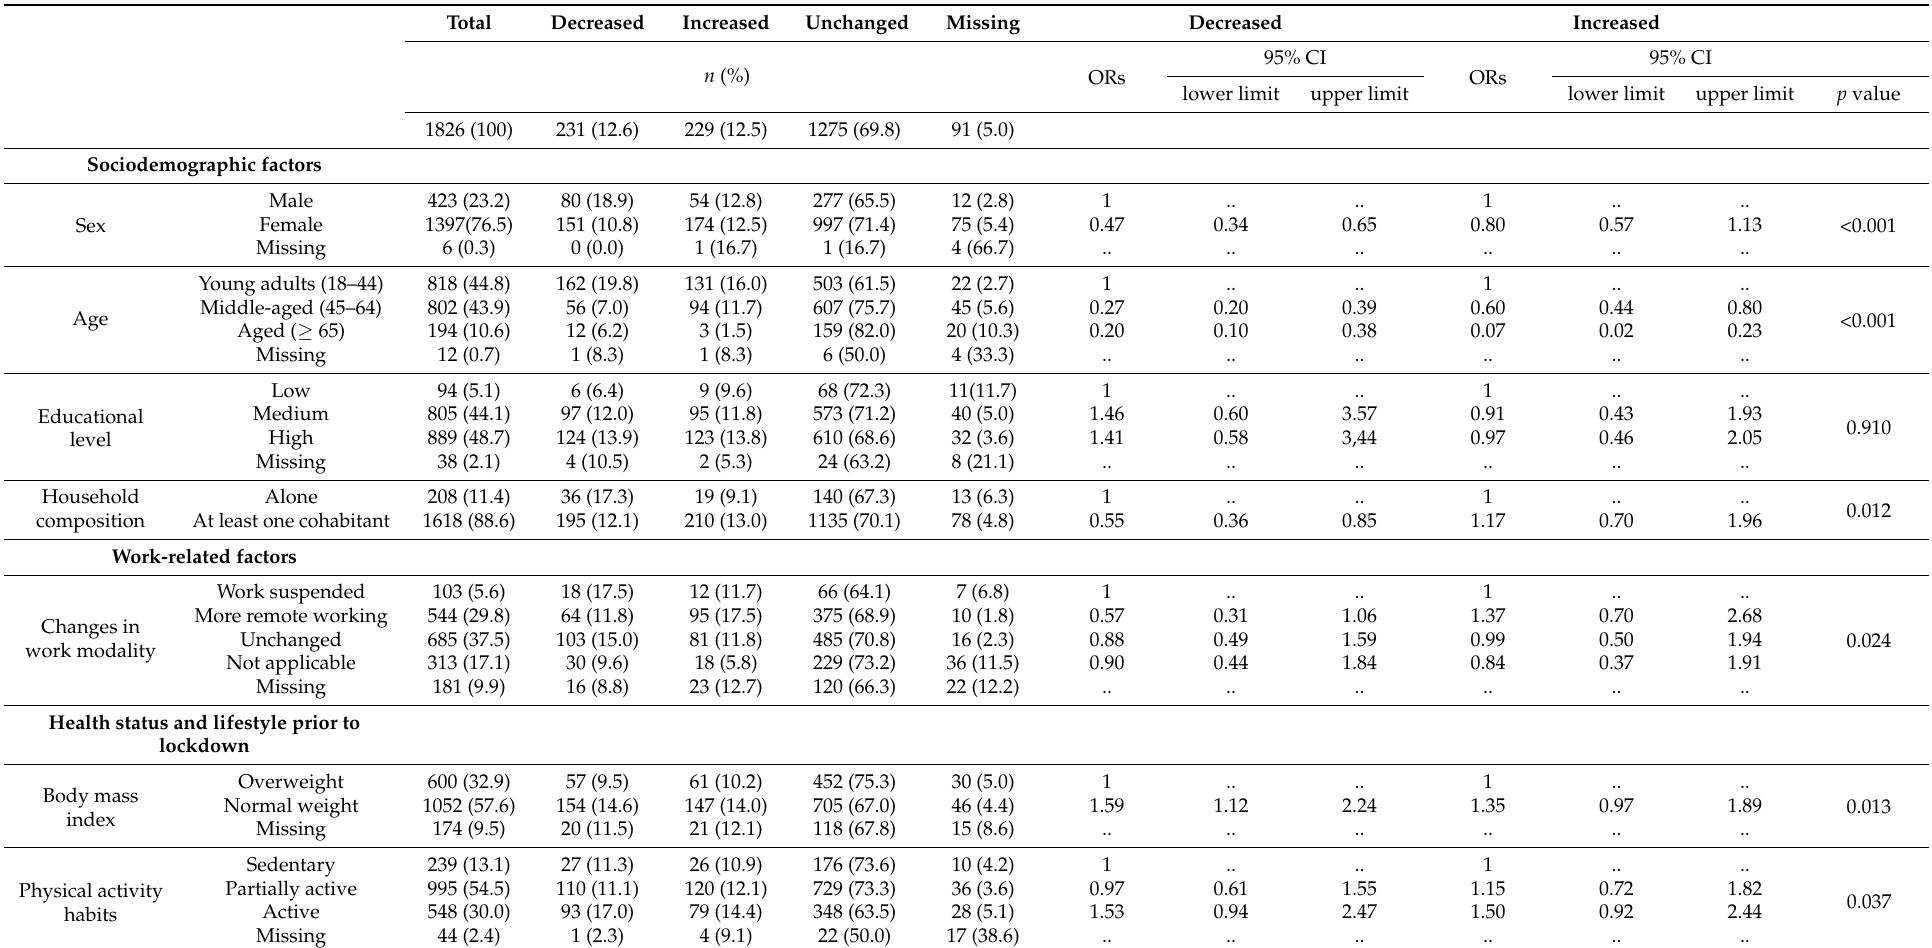
Table 4. Odds ratio for type of change in alcohol drinking (decreased, increased, or unchanged) during COVID-19 lockdown by sociodemographic and work-related factors, health status, and lifestyle prior to lockdown, and psychological